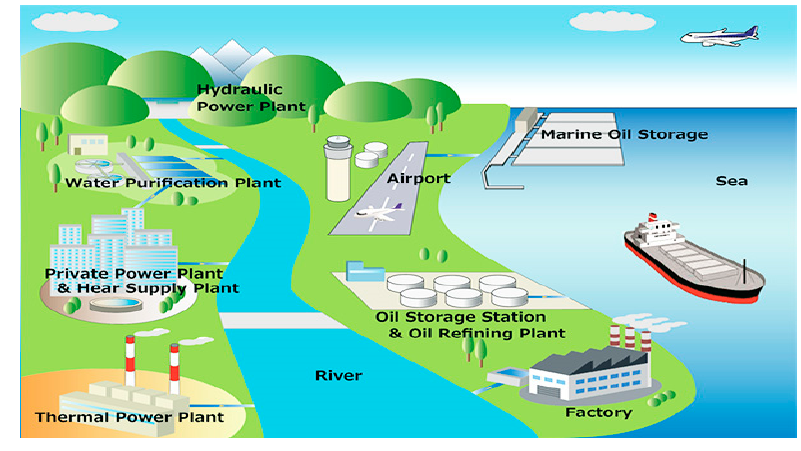
Figure 3. Environment monitoring system.